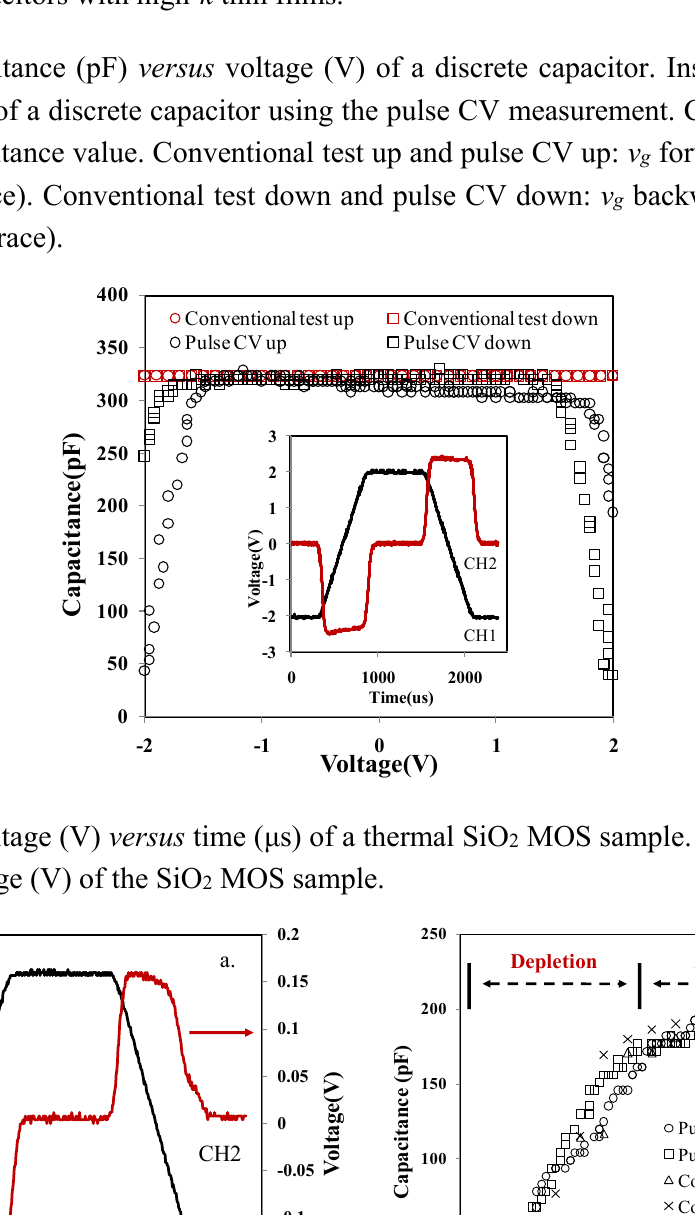
Figure 3. Capacitance (pF) versus voltage (V) of a discrete capacitor. Inset: Voltage (V)